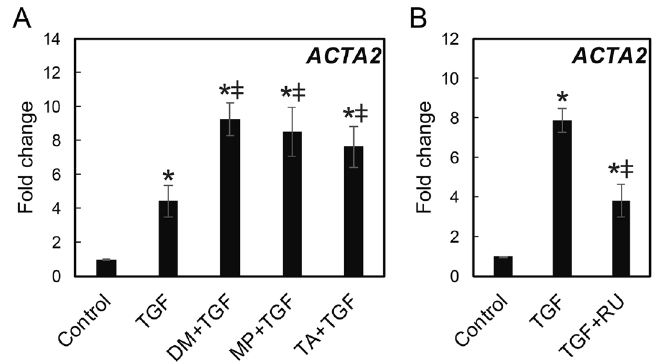
Figure 2. Expression levels of ACTA2 genes in TGF ‐ β1-induced vocal fold fibroblasts after glucocorticoids and RU486 administration. HVOX cells were treated with TGF-β1 (TGF-β1; 10 ng/mL), dexamethasone (DM; 10 −7 M), methylprednisolone (MP; 10 −5 M), triamcinolone (TA; 10 −5 M), and/or RU486 (RU; 10 −6 M) for 24 h ( A , B ), and ACTA2 mRNA expression was examined by qPCR. Relative expression levels of ACTA2 to GAPDH were compared with those of the control group, and are shown as mean ± SEM (n = 3). * P < 0.05 vs. control. ǂ P < 0.05 vs